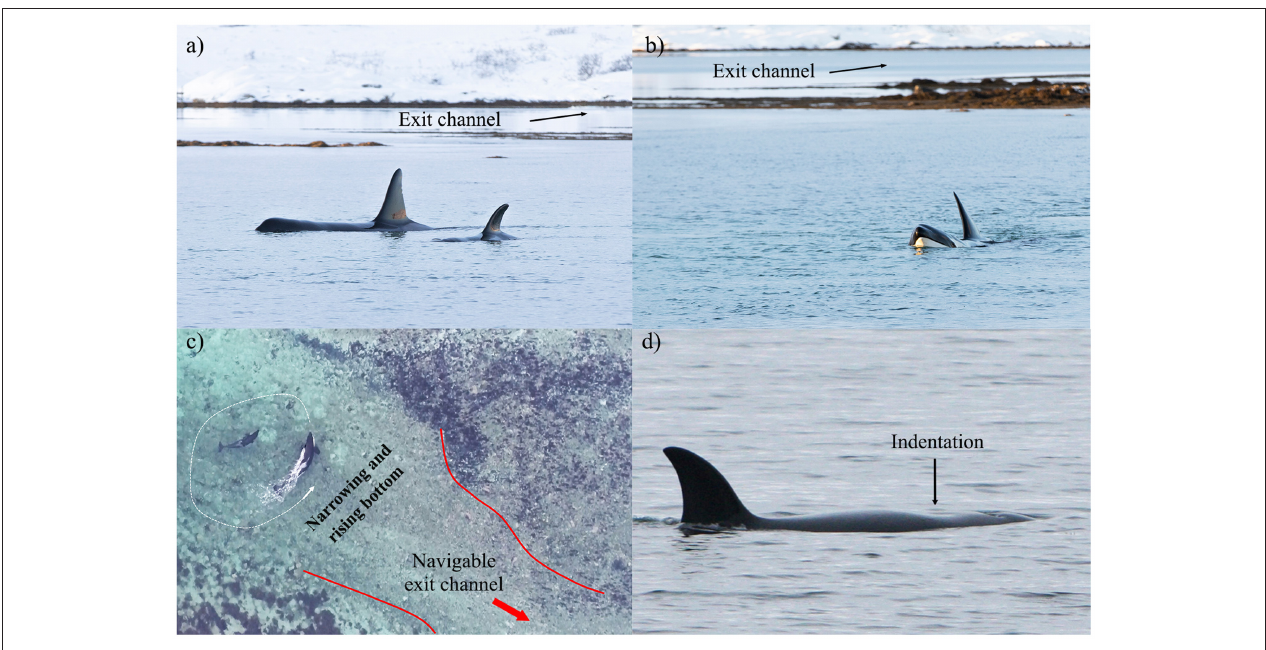
FIGURE 4 | Observations that may be used as cues of killer whales being entrapped: (a) long periods spent motionless at the surface intermittent with (b) stereotyped pacing back and forth in front of the mouth of the exit channel leading to (c) consistent turnarounds due to sudden narrowing and rising bottom (Case #19); (d) indentation behind the blowhole indicative of a decreased blubber thickness and nutritional stress (Case